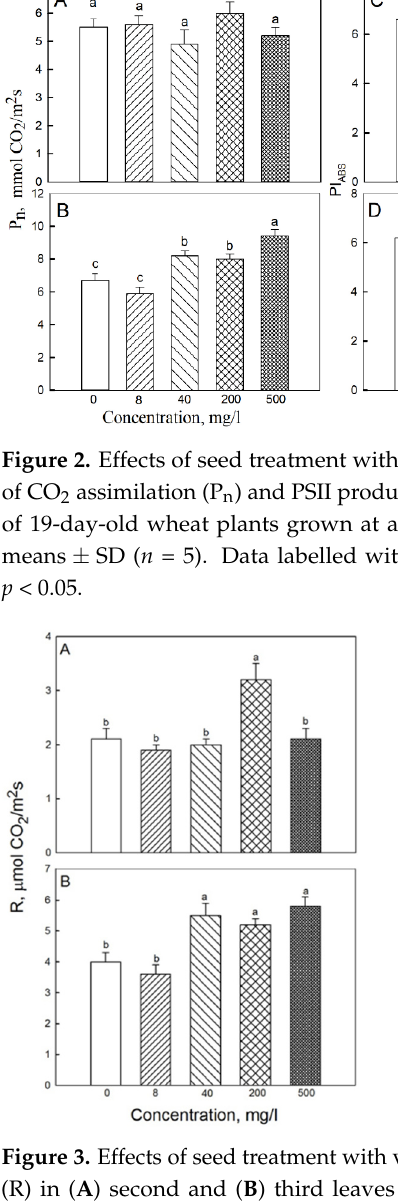
Figure 4. Effects of seed treatment with various concentrations of Fe 3 O 4 nanoparticles on the rate of ( A ) CO 2 assimilation and ( B ) respiration in third leaves of 19-day-old wheat plants grown at light intensity 120 μ mol (photons) m − 2 s − 1 . Data are means ± SD ( n = 5). Data labelled with different lower- case letters are significantly different at p < 0.05. 2.3. Photochemical Activity The photochemical activity assessed by PI ABS was practically the same for the third and second leaves when comparing any of the treatments with each other (shown for 19- day-old plants in Figure 2). With 200 mg L − 1 NP treatment, the content of Chl a, Chl b was higher in the second and third leaves than in the control; in the third leaf, beneficial effects